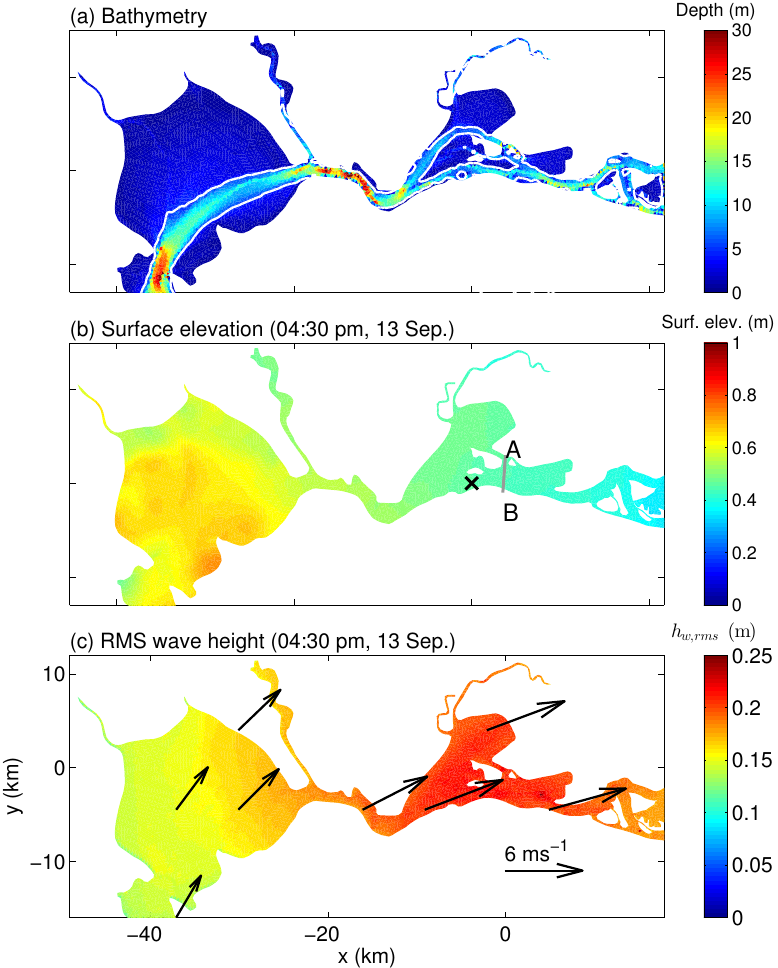
Figure 4. Model bathymetry (in m below the mean higher high water (MHHW)) of North San Francisco Bay ( a ), following Chua and Fringer [42], in which the white contours indicate a depth 5 m to separate shallow-water shoals (depth < 5 m) from the deep channel (depth > 5 m), and modeled surface elevation ( b ) and RMS wave height ( h w , rms ) ( c ) at 4:30 p.m. on 13 September 2009. The cross in ( b ) indicates the location of the point measurement of SSC and wave height. Distances are relative to the point measurement marked by the cross in ( b ). The gray solid line ( AB ) in ( b ) indicates the transect of SSC profiles presented in Figure